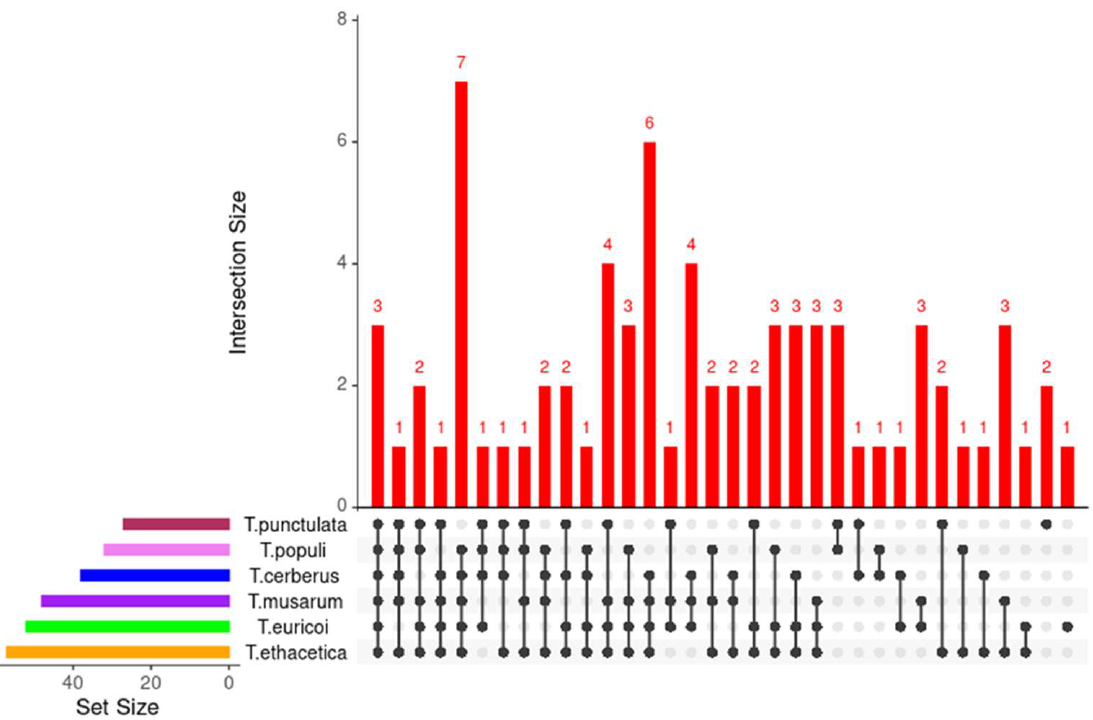
Figure 7. Orthologues of putative effector proteins in Thielaviopsis species. The number of orthologue genes shared by T. punctulata and its closely related species is shown as a red bar. The size of clusters in species is represented by different colors. Dots and lines connect the species with shared orthologues. The figure is generated by UpsetR.